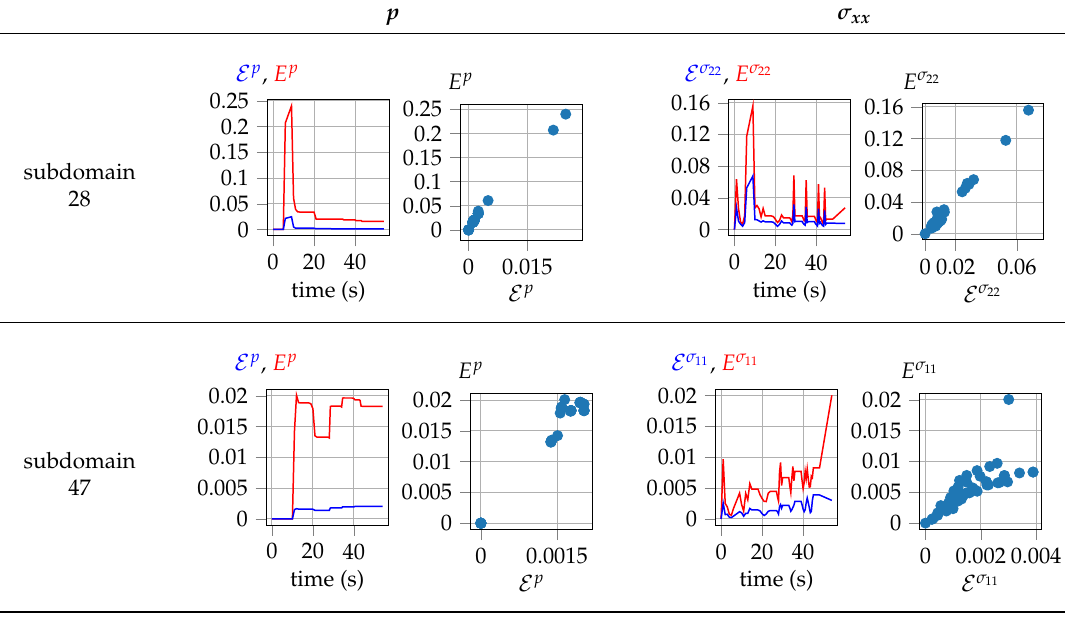
Table 7. Illustration of the correlation between the ROM-Gappy-POD residual E (13) and the error E (12) on the dual quantities cumulated plasticity p and a component of the stress tensor σ . p σ xx